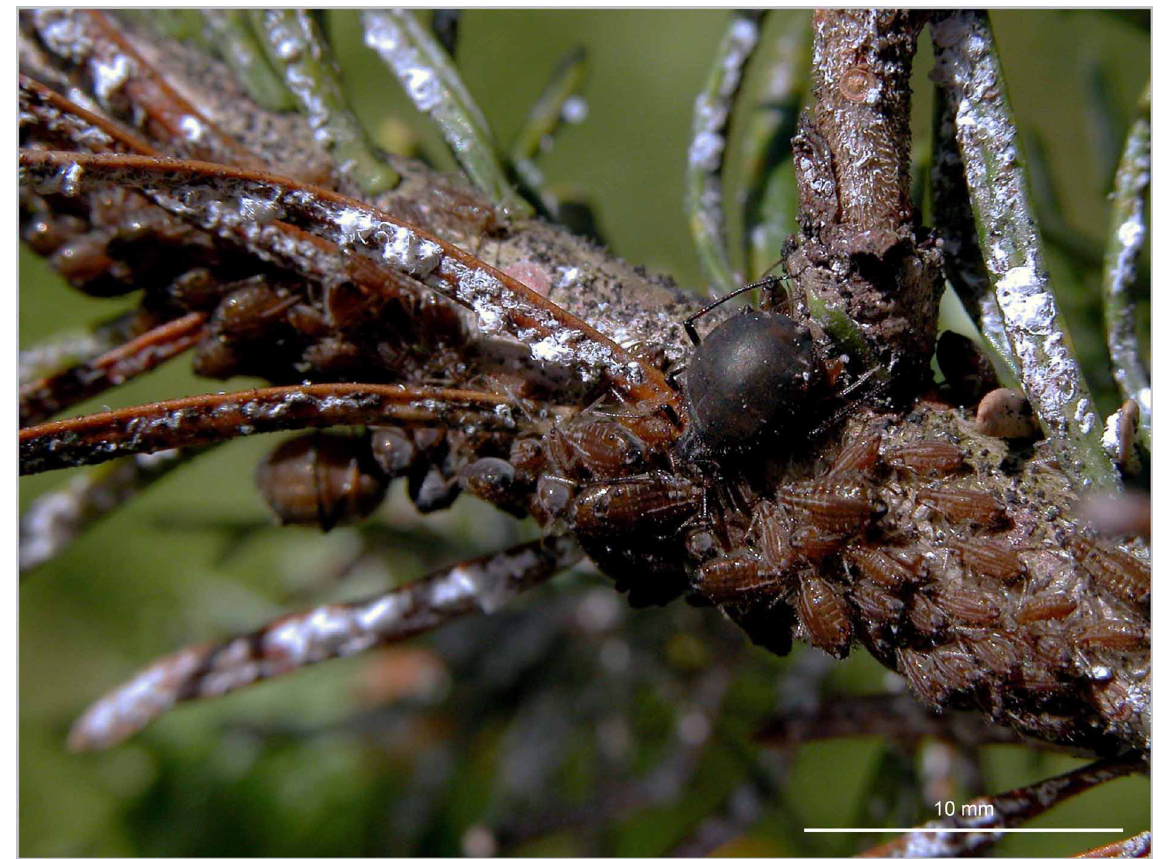
Fig. 51. Cinara (Cinara) confinis Koch, 1856. Colony on branch of Abies sibirica . Needles strongly infested by Adelges (Aphrastasia) pectinatae (Cholodkovsky,